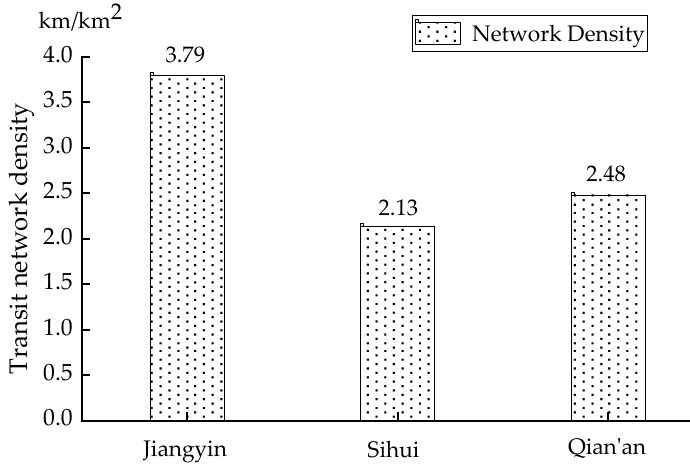
Figure 6. Network density and the number of synchronizations.